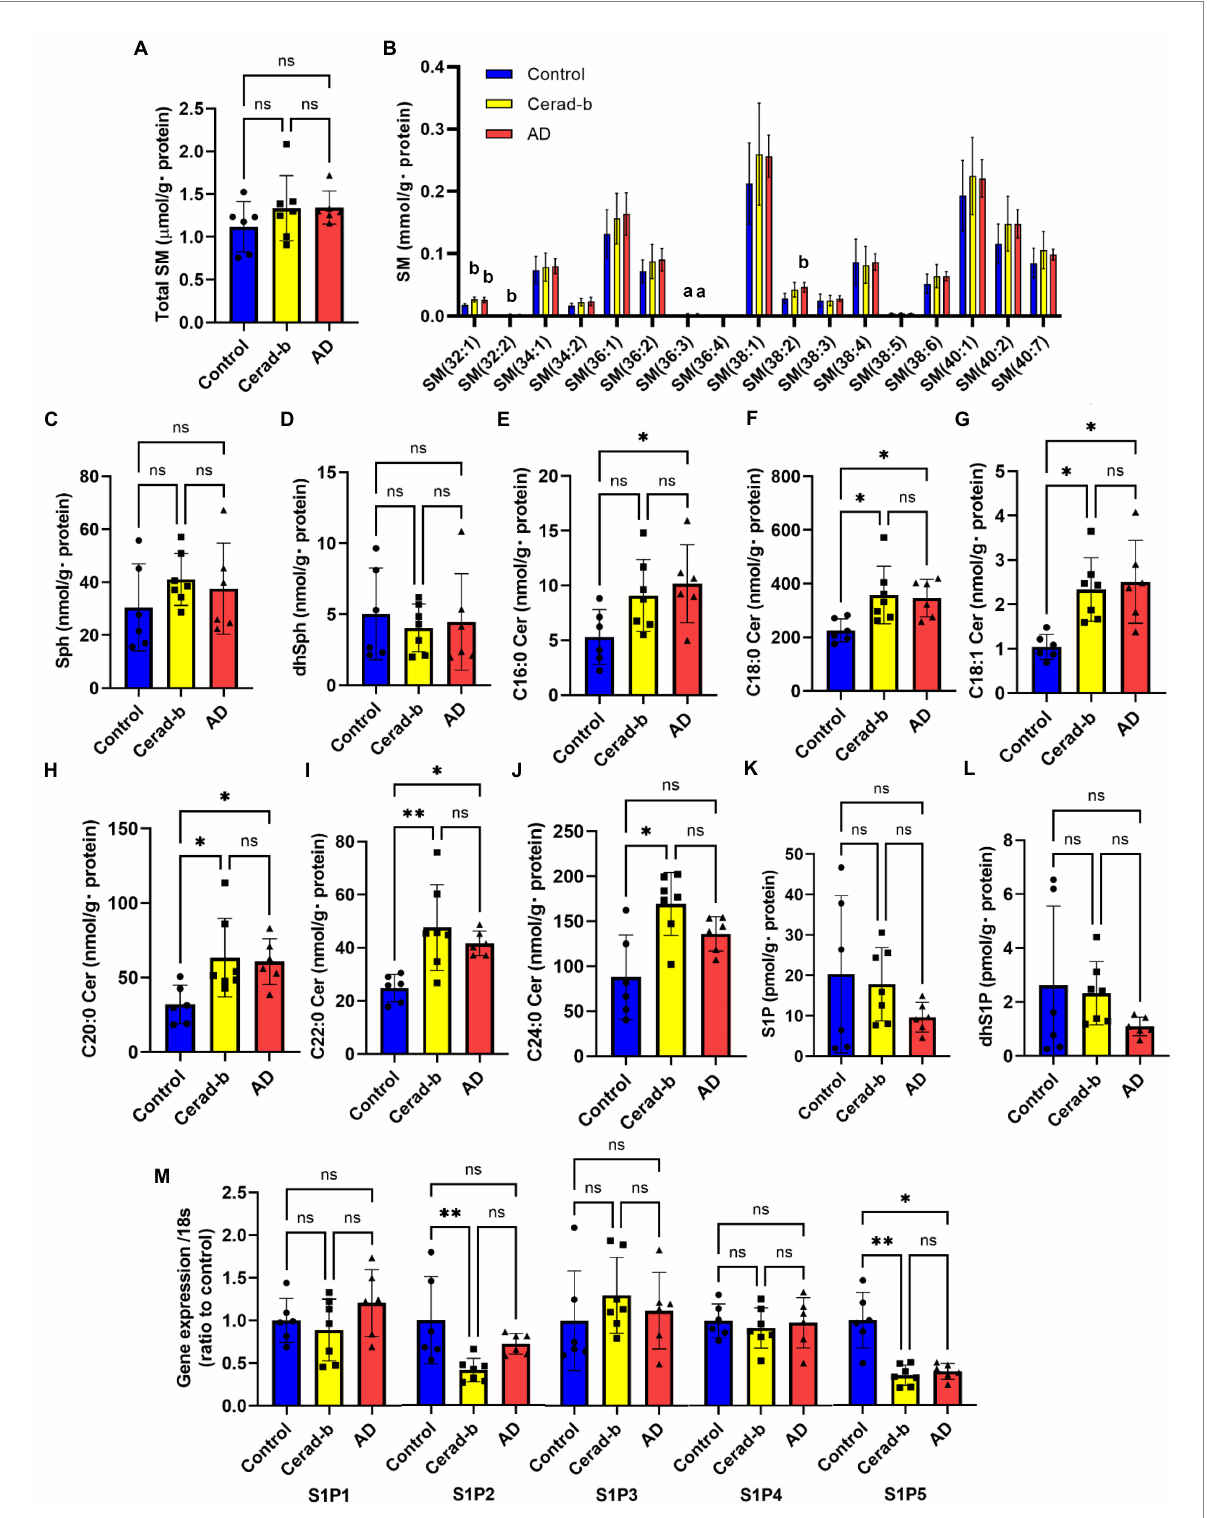
FIGURE 1 Modulations of sphingolipid levels and mRNA levels of S1P receptors in the brain of AD and Cerad-b. The sphingolipid levels and the mRNA levels of S1P receptors were measured in the brain of control subjects ( n = 6), the patients with Cerad-b ( n = 7), and those with AD ( n = 6). The Kruskal-Wallis test, followed by the Steel-Dwass test as a post-hoc test, was used for statistical evaluation of the differences. (A) Total SM levels. (B) The brain levels of SM species. (C) Sph levels. (D) DhSph levels. (E–J) The brain ceramide levels. (K) S1P levels. (L) DhS1P levels. (M) The mRNA expression levels of S1P receptors adjusted to the expression level of 18 s as the internal standard. * p < 0.05; ** p < 0.01; ns, not significant; a, p < 0.05 vs. control; b, p < 0.01 vs. control; c, p < 0.001 vs. control; d, p < 0.05 between Cerad-b and AD; e, p < 0.01 between Cerad-b and AD; f, p < 0.001 between Cerad-b and